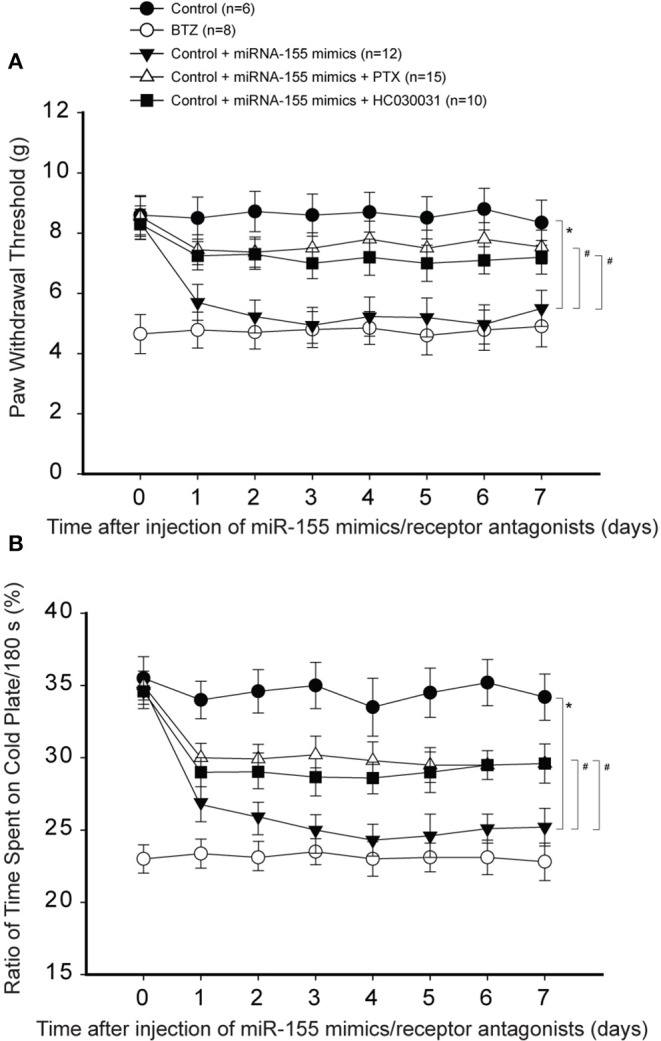
Effects of blocking TNFR1 and TRPA1 on mechanical and cold sensitivity. TNF-α signal was inhibited by pentoxifylline (PTX; 10 μg each day over three consecutive days). TRPA1 was blocked by administration of HC030031 (5 μg each day over three consecutive days). (A) PWT was smaller in BTZ than that in control rats for all time courses. As compared with controls, intrathecal injection of miR-155 mimics (3 μg each day over three consecutive days) significantly decreased PWT, and the effects of miR-155 mimics were attenuated by injection of PTX and HC030031. (B) showing that % time spent on the cold plate was less in BTZ rats and in rats with injection of miR-155 mimics. PTX and HC030031 attenuated the effects of miR-155 mimics. *P < 0.05, control rats vs. control rats with mimics; #P < 0.05, rats with mimics vs. rats with mimics plus PTX or mimics plus HC030031. The number of rats in each group was shown on the figure.